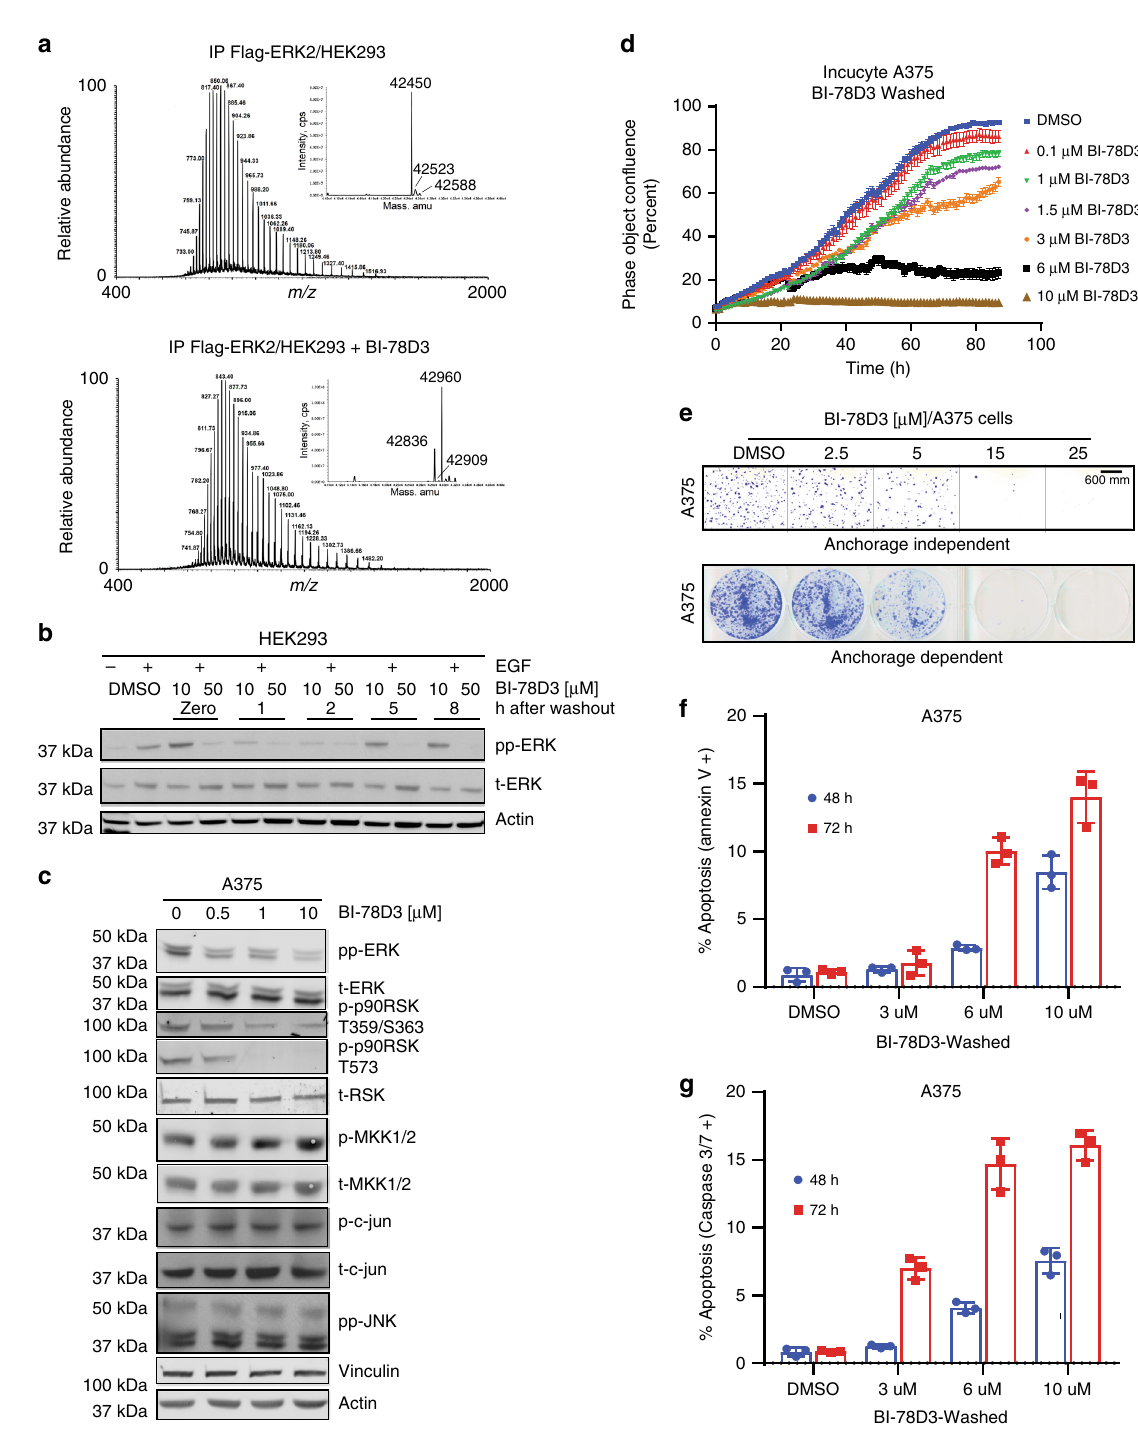
Fig. 4 BI-78D3 labels ERK2 in cells. a BI-78D3 labels Flag-ERK2 covalently in HEK-293 cells. b Sustained inhibition of EGF-stimulated ERK phosphorylation by incubating HEK cells with BI-78D3 for 2 h, followed by washout. Immunoblots were performed in duplicate using pan-actin as a control. Images have been cropped for presentation, uncropped images are shown in Supplementary Fig. 25. c Inhibition of EGF-stimulated ERK activation, but not JNK activation by BI-78D3 in BRAF- mutant A375 melanoma cells. 1.5 million cells were seeded in 60 mm dish, serum starved overnight, treated with BI-78D3 for 1 h in serum-free media, followed by inhibitor washout for 2 h in the same media. Cells were then stimulated with EGF for 30 min in full media. This experiment was performed three times. Pan-Actin was employed as a control in each experiment. Images have been cropped for presentation, and uncropped images are shown in Supplementary Fig. 25. Two more replicates are shown in Supplementary Fig. 25b. d Treatment of A375 cells with BI-78D3 for 1 h in full media, followed by washout, inhibits their approach to con fl uence in a dose-dependent manner (IncuCyte imaging. Error bars: SEM ( n = 3), represents one experiment of at least three repetitions). e BI-78D3 inhibits anchorage-dependent and anchorage-independent growth of A375 cells in a dose-dependent manner (the experiments were performed in triplicate). Scale bar represents 600 µ m. f , g BI-78D3 induces apoptosis of A375 cells in a dose-dependent manner, as determined by Annexin V or Caspase-3/7 assays (IncuCyte imaging. Error bars: SEM ( n =